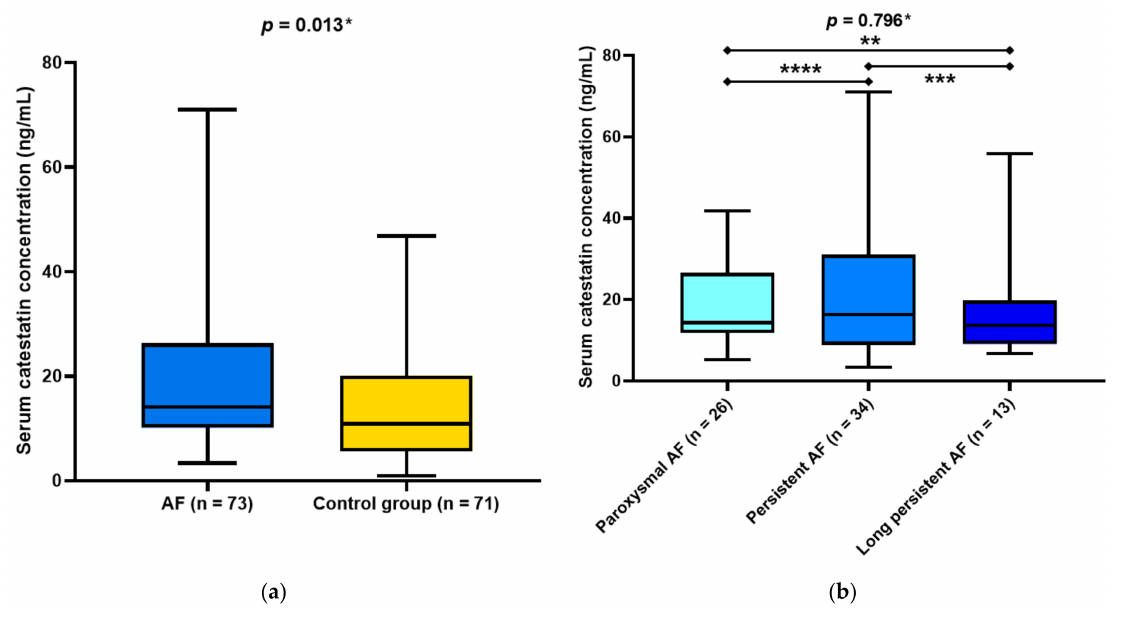
Figure 1. ( a ) Comparison of catestatin concentrations between patients with atrial fibrillation and healthy controls. Data are presented as median and interquartile range. * Mann–Whitney U test. ( b ) Comparison of catestatin concentrations between subgroups of patients with atrial fibrillation. Data are presented as median and interquartile range. * Kruskal–Wallis test ** p = 0.447 *** p = 0.634 **** p = 0.911.